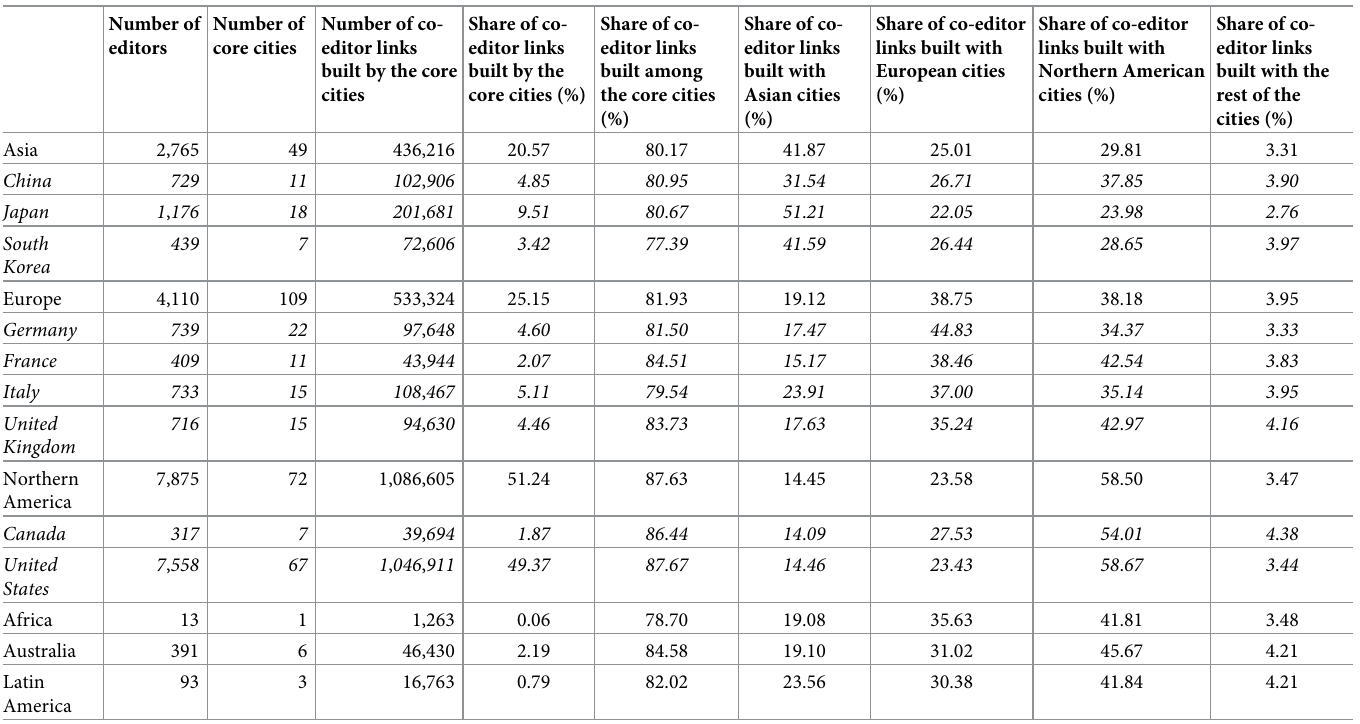
Table 2. Co-editor link distribution of core cities by